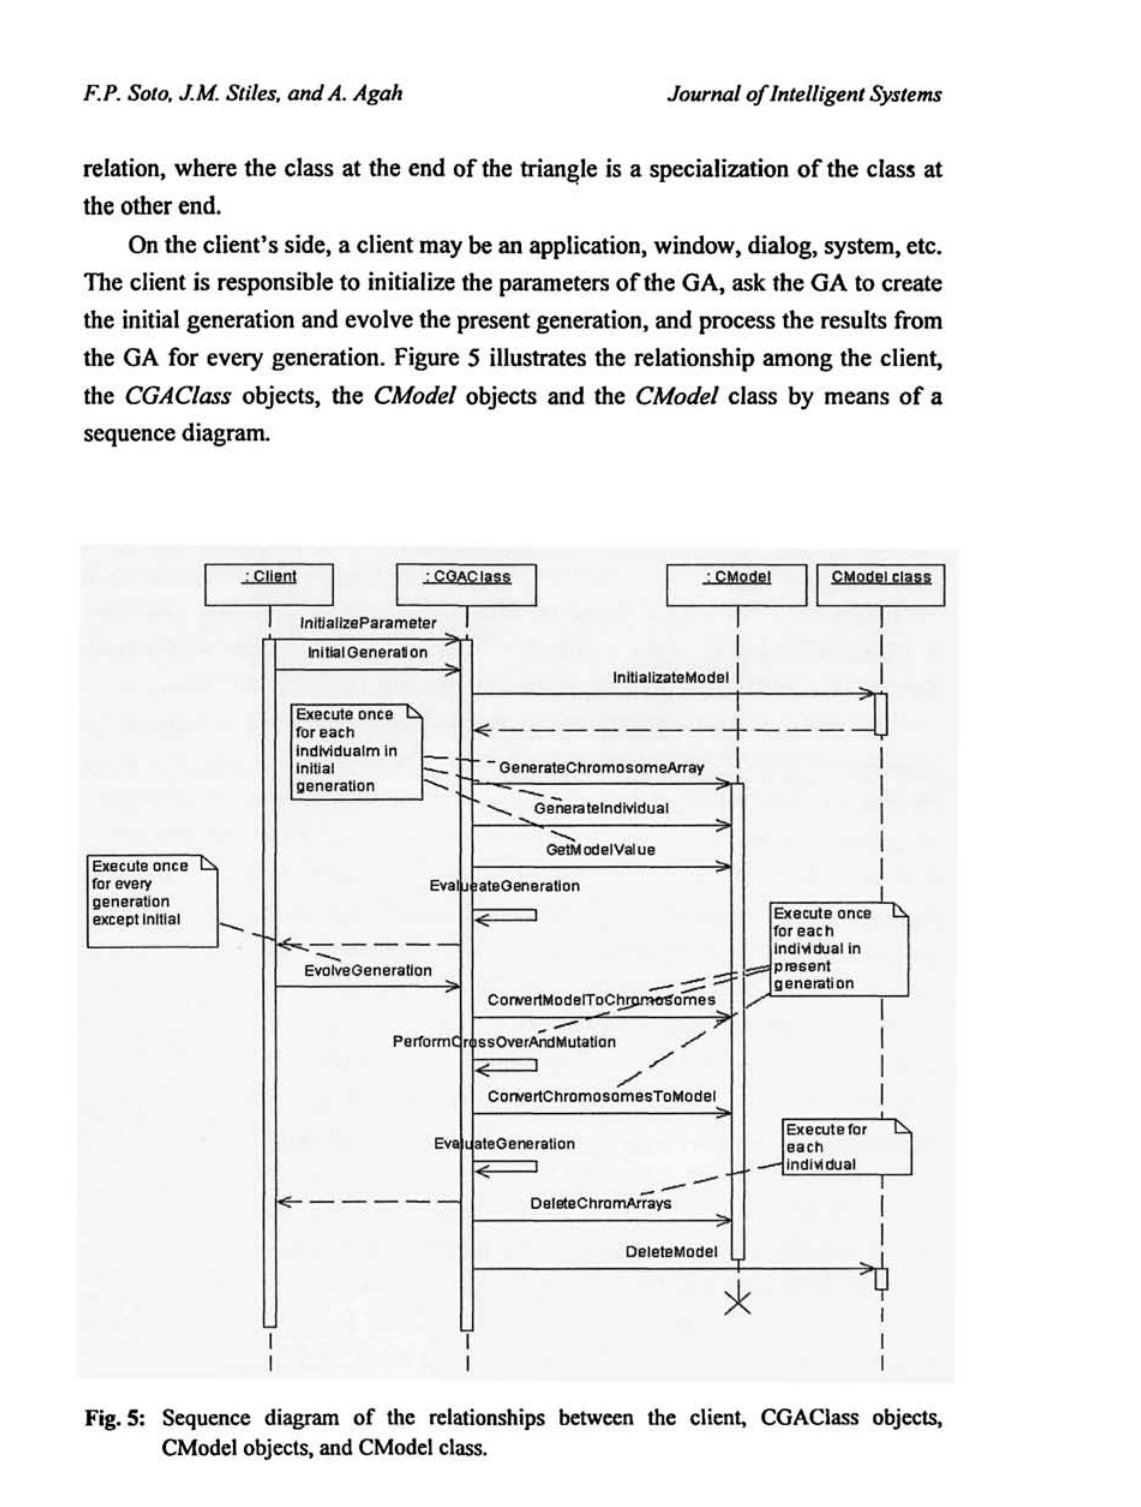
Fig. 5: Sequence diagram of the relationships between the client, CGAClass objects, CModel objects, and CModel